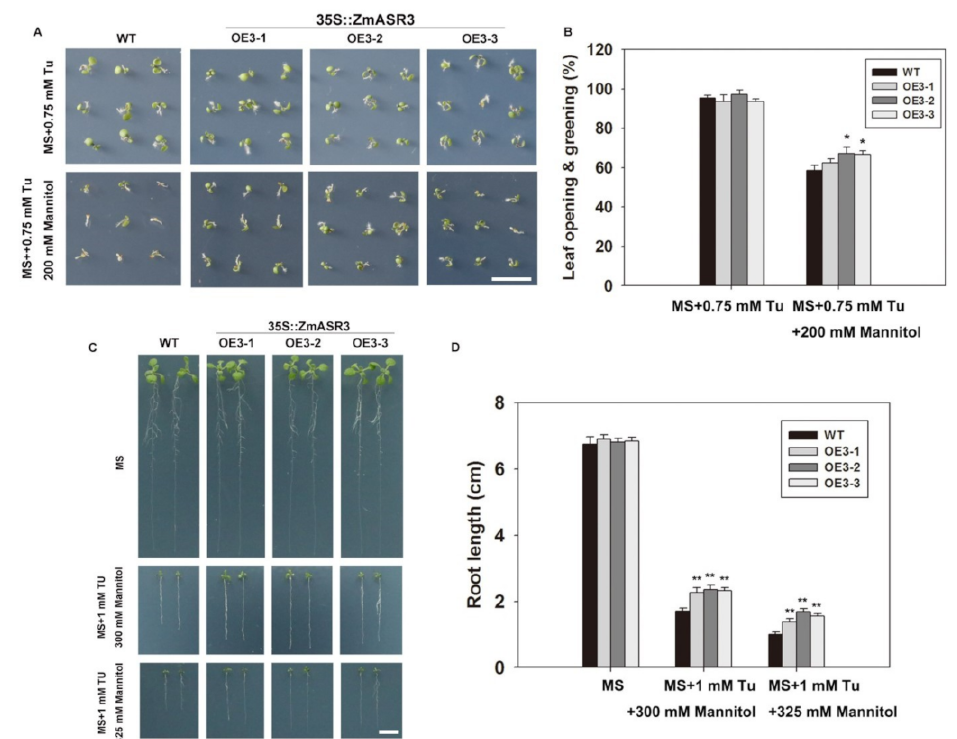
Figure 10. ABA signaling is involved in induction of ZmASR3 with mannitol treatment. ( A ) Analysis of the germination of the three transgenic lines and wild-type plants. Seeds were germinated and grown for eight days on half MS medium containing 0.75 mM Tu and 0.75 mM Tu + 200 mM mannitol. ( B ) Germination rates of seeds shown in ( A ), as counted by leaf opening and greening. All samples were measured in triplicate. ( C ) Three-day-old seedlings grown on MS medium were transferred to fresh medium containing 1 mM Tu + 300 mM mannitol and 1 mM Tu + 325 mM mannitol for seven days. ( D ) Root lengths of the seedlings shown in ( C ). For ( B , D ), Scale bar = 1 cm vertical bars indicate means ± S.E. ( n ≥ 3). Significant di ff erences: * p < 0.05; ** p < 0.01.